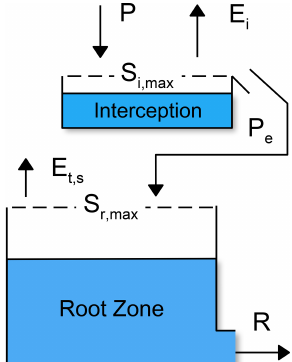
Figure 3. Conceptual model for the nonlinear recharge model. S i , max and S r , max are the maximum capacities of the interception and root zone reservoirs, respectively. E i is the interception evapo- ration, and E t , s is a combined flux consisting of transpiration and soil